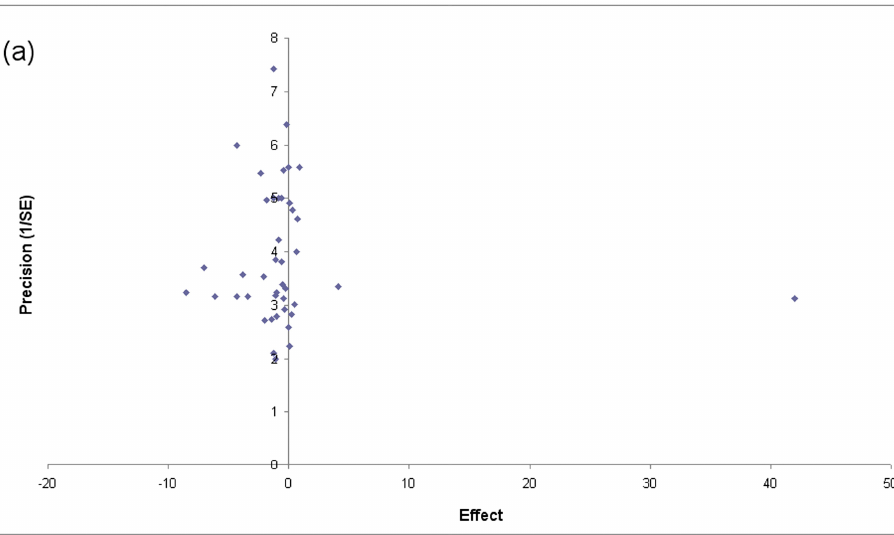
Figure 4. ( a ) Funnel plot for meta-analysis related to serum Zn; ( b ) Funnel plot for meta-analysis related to plasma Zn. 4. Discussion This review of the literature on the possible linkage between zinc levels (especially in serum and plasma) and autoimmune diseases has revealed a huge amount of studies on this subject, although the selection due to meta-analysis methods has narrowed the final analysis to 62 publications, temporally distributed as shown in Figure S1 (Supplemental Material). As expected, the data presented in this review, although very heterogeneous in the manner of collecting and investigating samples, etc., have proved to be extremely consistent in witnessing a deficiency of zinc in serum and plasma of patients compared to controls. A recurring question found in many studies was whether alterations in the homeostasis of this element represent the basis of the inflammatory status or consequences thereof. As is well known, there are populations such as Finnish or Sardinian with polygenic predisposition to autoimmune diseases, in whom there has been a natural selection in favor of certain genetic loci, playing a role in the immune response. In particular, certain HLA (Humane Leucocyte Antigens) haplotypes, such as HLA-DR3-B18 in Sardinia and HLA-DR4 in Finland, are particularly frequent in those populations, terribly increasing the relative risk of developing multiple sclerosis [83], type 1 diabetes [84] and even comorbidity of these two and other autoimmune pathologies [85]. In addition, recent works have also shown that DNA genetic variations largely drive the development